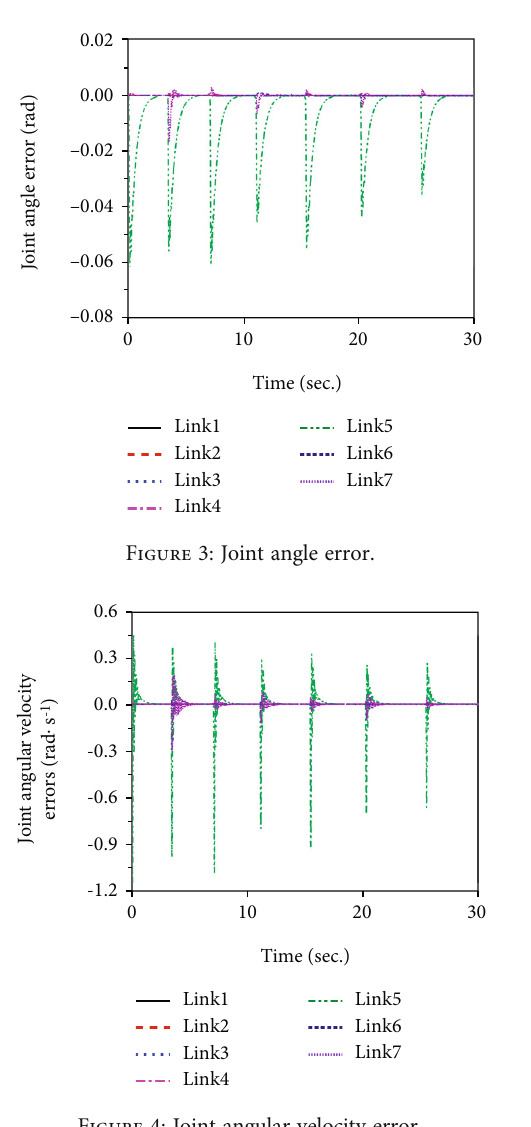
Figure 4: Joint angular velocity error.